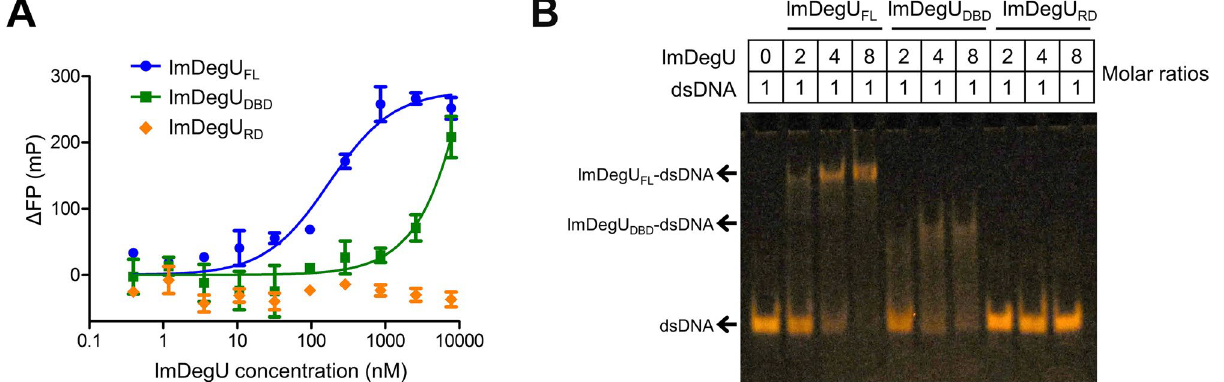
Figure 5. Enhancement of the DNA-binding capacity of lmDegU by the RD. ( A ) dsDNA-binding levels of lmDegU FL , lmDegU DBD , and lmDegU RD based on the FP assay. The data (means ± S.D.) are representative of three independent experiments that yielded similar results. ( B ) dsDNA-binding capacities of lmDegU FL , lmDegU DBD , and lmDegU RD based on the EMSA. The gel image is representative of three independent experiments that yielded similar results. The full-length gel is shown in Supplementary Fig.